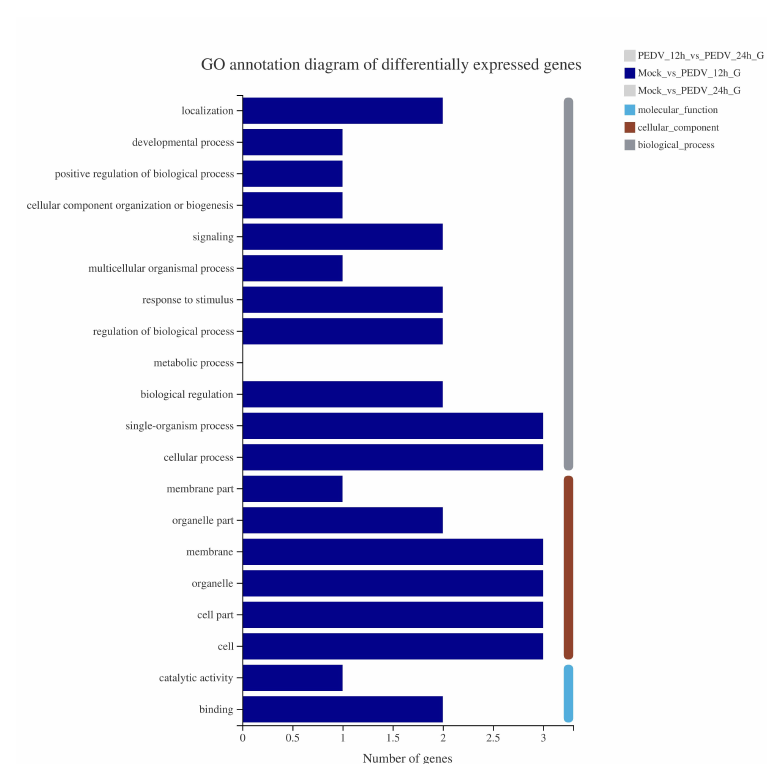
Figure 3. GO function annotation of differentially expressed genes of PEDV 12 h vs. PEDV 24 h and Mock vs 24h ( a ) Mock vs 12 h ( b ).